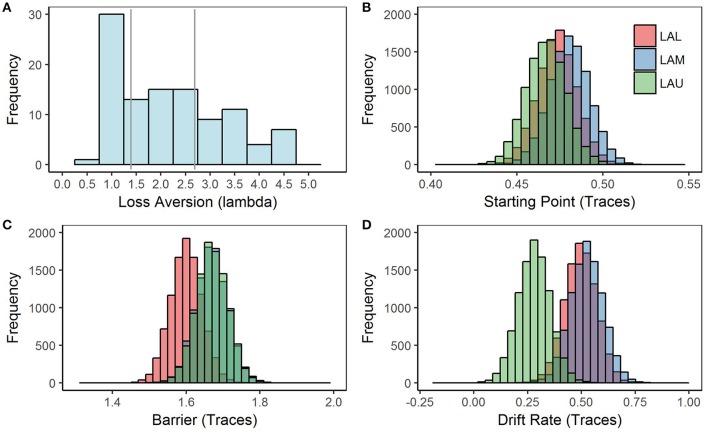
LA Histogram and Model 1 posterior distributions for each parameter by loss aversion group. Model 1 was estimated using a Bayesian hierarchical framework, with Markov chain Monte-Carlo (MCMC) sampling methods employed to estimate a joint posterior distribution (known as traces) for each of the model parameters, starting point, barrier, and drift rate. (A) Histogram of loss aversion scores with gray lines separating each tercile group. Our participant sample was more loss averse (M = 2.17, SD = 1.14), as measured by the DOSE using the lambda (λ) parameter than samples in the literature; although, our study had the benefit of a larger sample size and fewer exclusions than is typical. Generally, scores on the DOSE where lambda > 1 are considered loss-averse and scores below 1 are considered loss-seeking. (B) Posterior distribution of starting point traces estimated by Model 1. Starting point traces are separated by the loss aversion groups. (C) Posterior distribution of barrier traces estimated by Model 1. Although barrier traces seem to somewhat separate based on loss aversion groups, the difference between groups is not significant. (D) Posterior distribution of drift rate traces estimated by Model 1. Drift rate traces are separated by the loss aversion groups, p < 0.05.